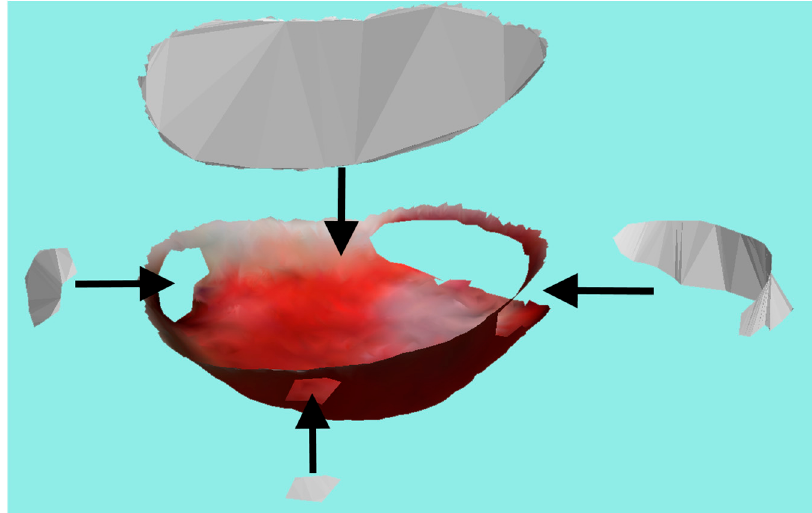
Figure 15. Final wound surface and created surfaces used for hole filling where arrows point to the actual location of the created surfaces.